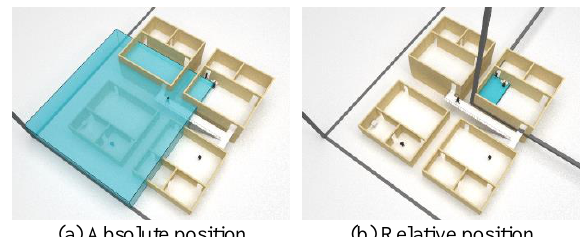
Figure 2. Position defines a pin point in space and it can be with reference to the origin of a global reference frame (left) or with reference to the origin of a local reference frame. The former and latter are referred to as absolute and relative positions respectively. 3.1 Position A Cartesian reference system is defined for the building. This is shown by the grey lines in figure 2. The absolute position of objects in the building are defined relative to this reference system. Note as discussed earlier, positions provide